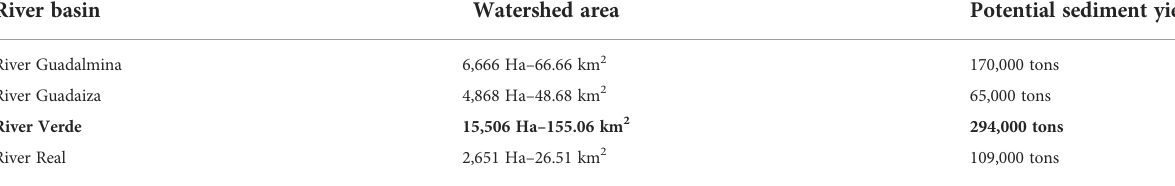
Commas were used in the second and third columns as a thousand separator and dots in the second column as a decimal separator. Result obtained in the river Verde watershed is highlighted in